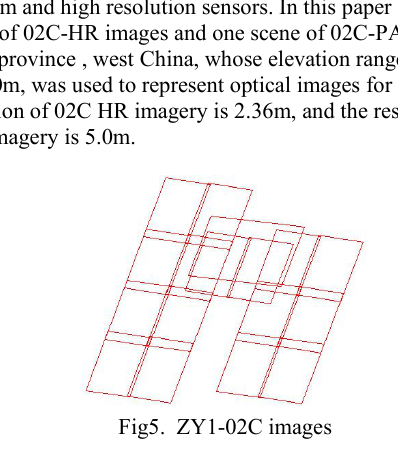
Table 3. Statistics for positioning accuracy of ZY1-02C